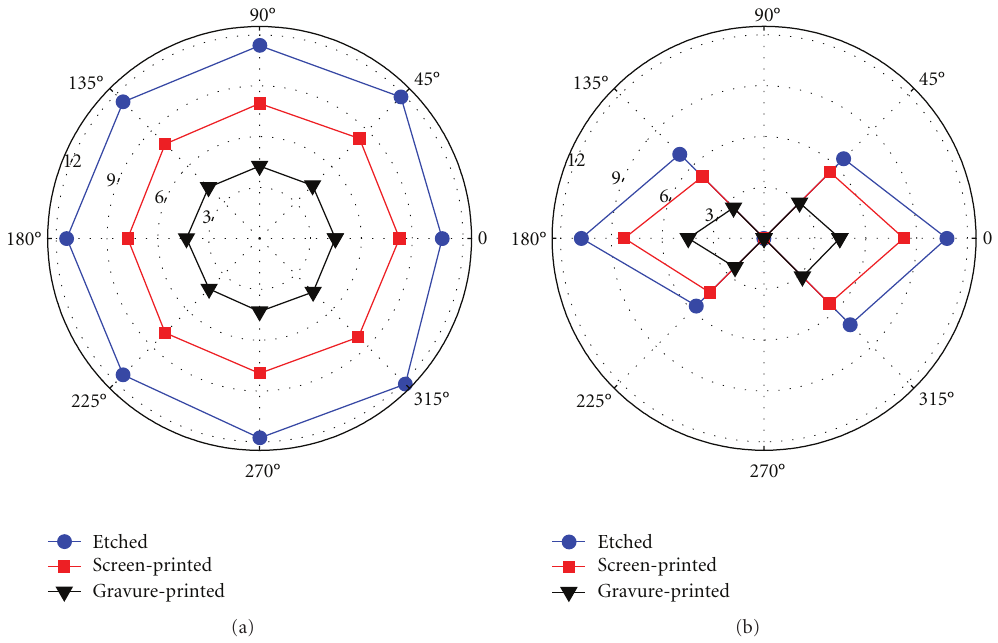
Figure 10: Measured detection ranges (m) at 866 MHz in two orthogonal planes, using 2 W ERP-power.